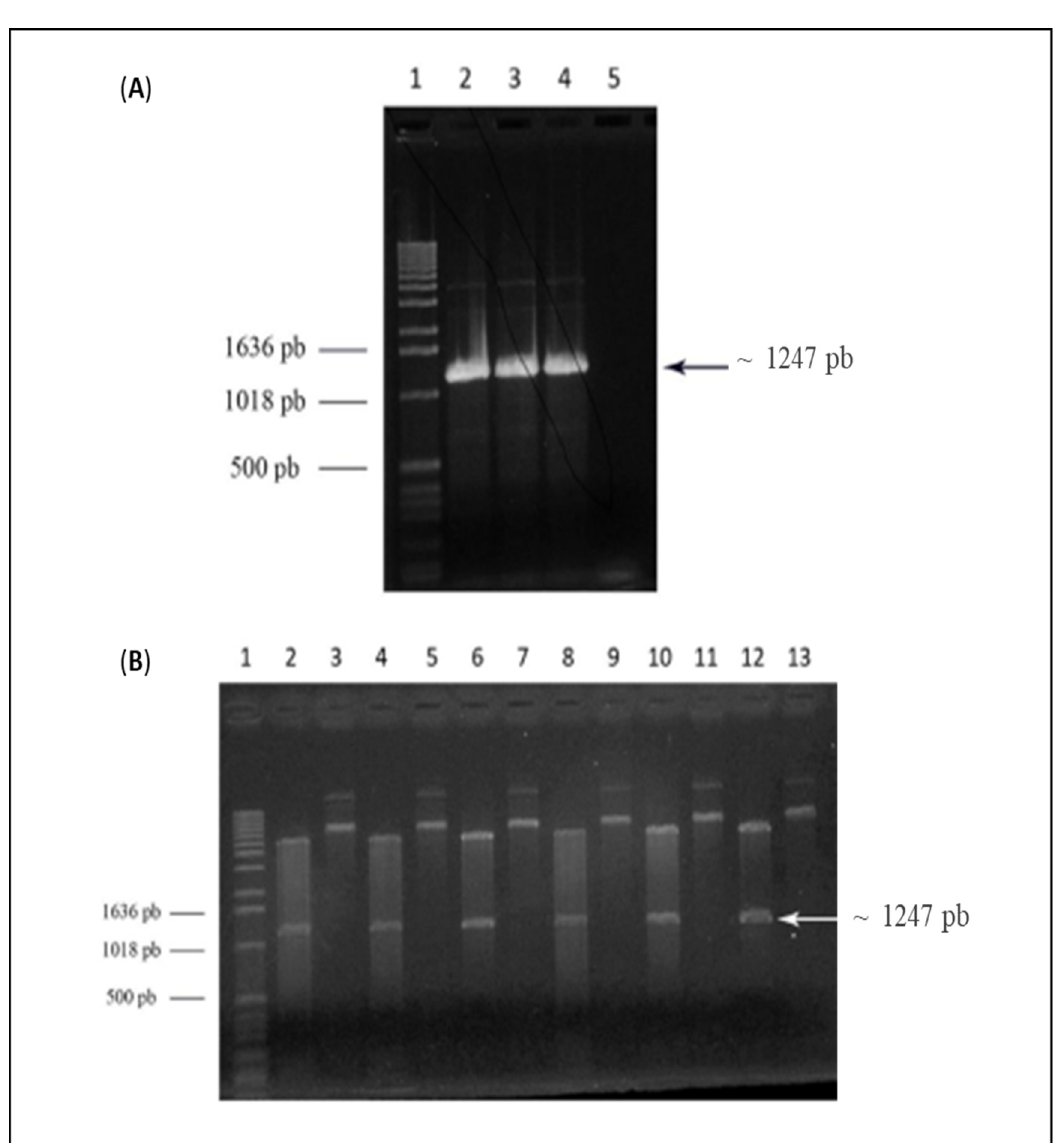
Figure 2. One percent agarose gel. ( A ) Electrophoresis of the PCR product of the Zika virus recombi- nant protein E (E-ZIKVre) gene in the commercial vector pUCIDT+E-ZIKVre. Lane 1—Molecular marker 1kb DNA Ladder™ (Life Technologies); line 2–4—PCR product E-ZIKVb; lane 5—negative control. ( B ) Electrophoresis of the enzymatic cleavage digestion products of the pET28a+E-ZIKVre